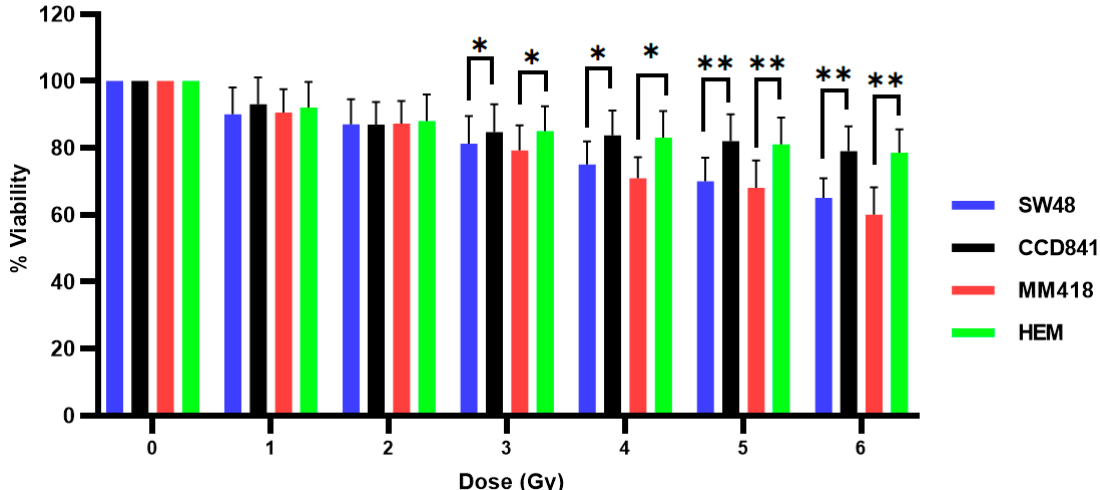
Figure 3. Effect of ionizing radiation (IR) on the viability of human colon adenocarcinoma (SW48) and melanoma (MM418- C1) cell lines compared to their non-cancerous counterparts (CCD841 and HEM cells). The cells were irradiated with 0–6 Gy X-rays and viability % was measured 48 h post-irradiation using the MTS assay. Results are expressed as the mean ± SEM of 3 replicates. Significance of different treatments compared to control is represented by black lines shown as * p < 0.05 and ** p < 0.01.